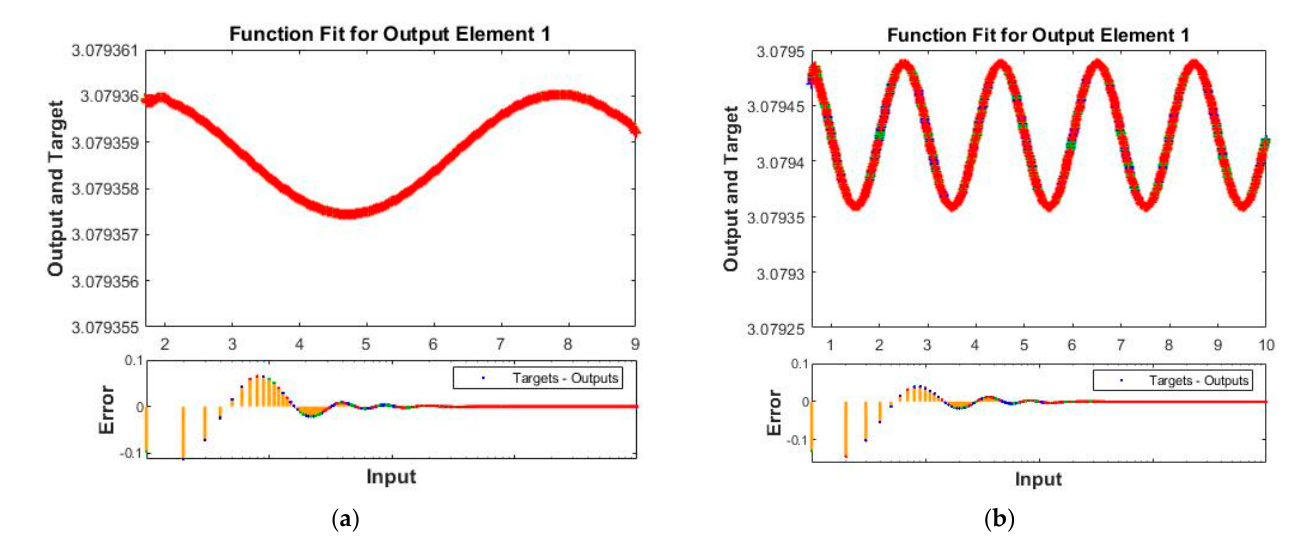
Figure 6. State transition containing gradient, step size, and validation checks of BRM-NNs for all four cases of the Dahl-based hysteresis model of piezoelectric actuator. ( a ) BRM-NNs Case 1. ( b ) BRM-NNs Case 2. ( c ) BRM-NNs Case 3. ( d ) BRM-NNs Case 4.